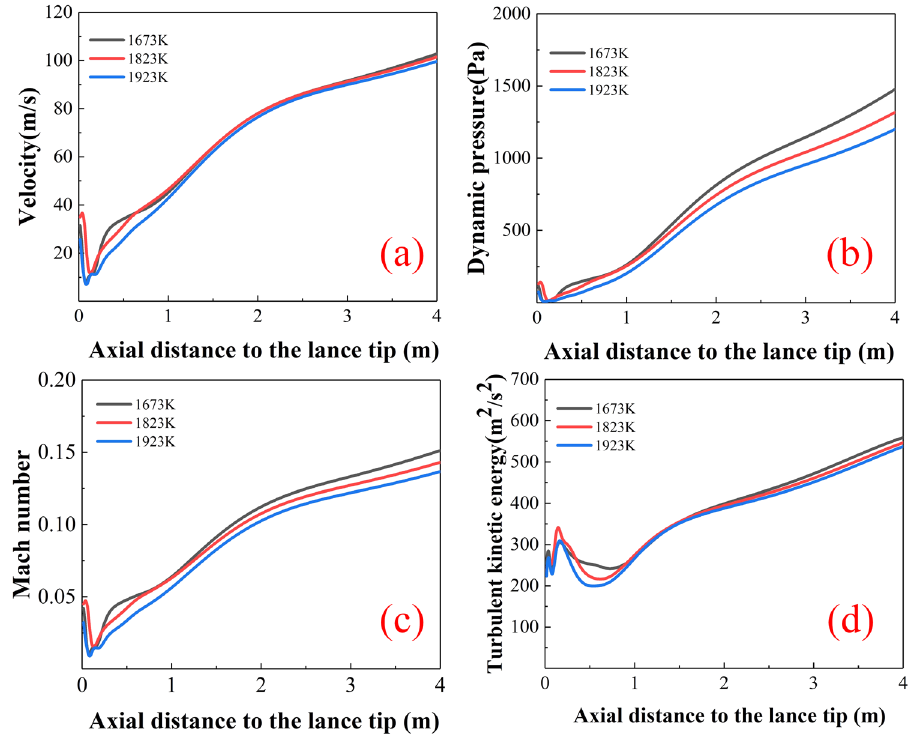
Figure 6: Jet characteristics of the nozzle centerline under di ff erent ambient temperatures: ( a ) velocity, ( b ) dynamic pressure, ( c ) Mach number, and ( d ) turbulent kinetic